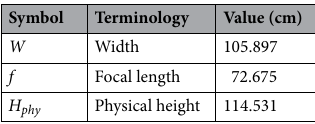
Table 3. Reflector parameters.